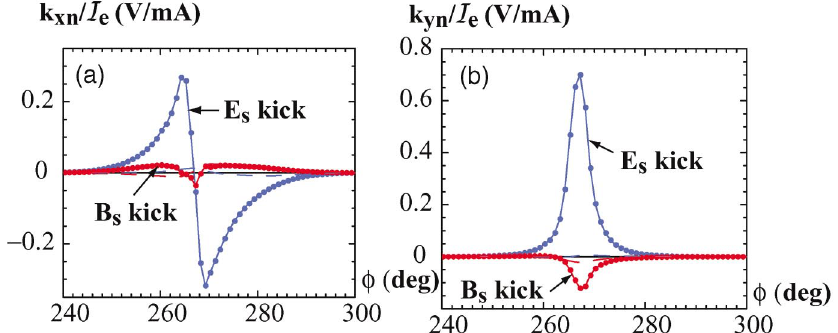
curves.FIG. 12. (Color) Space charge part of electric field components E particle on the rf crest for the example of Fig. 4(a). The fields are normalized to average emitted dark current. Color code indicates relative macroparticle charge.